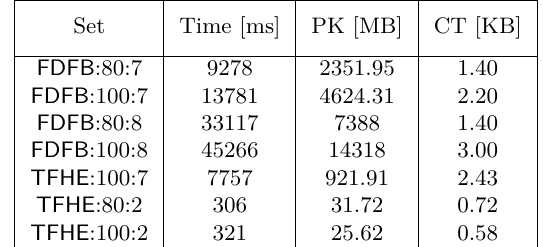
Table 5: Complexity for the parameter sets. We computed the size of the keys and ciphertexts by taking the byte size of every field element and counting the number of field elements.